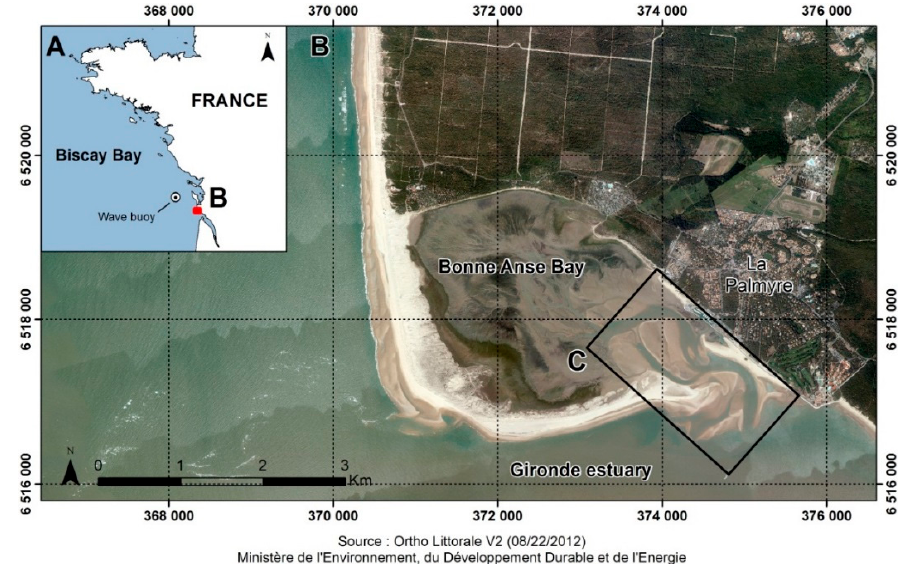
Figure 1. Location of the study area ( A ) on the Atlantic coast of France; ( B ) the Bonne-Anse Lagoon-Inlet; and ( C ) the study area (Lambert 93 Projection).